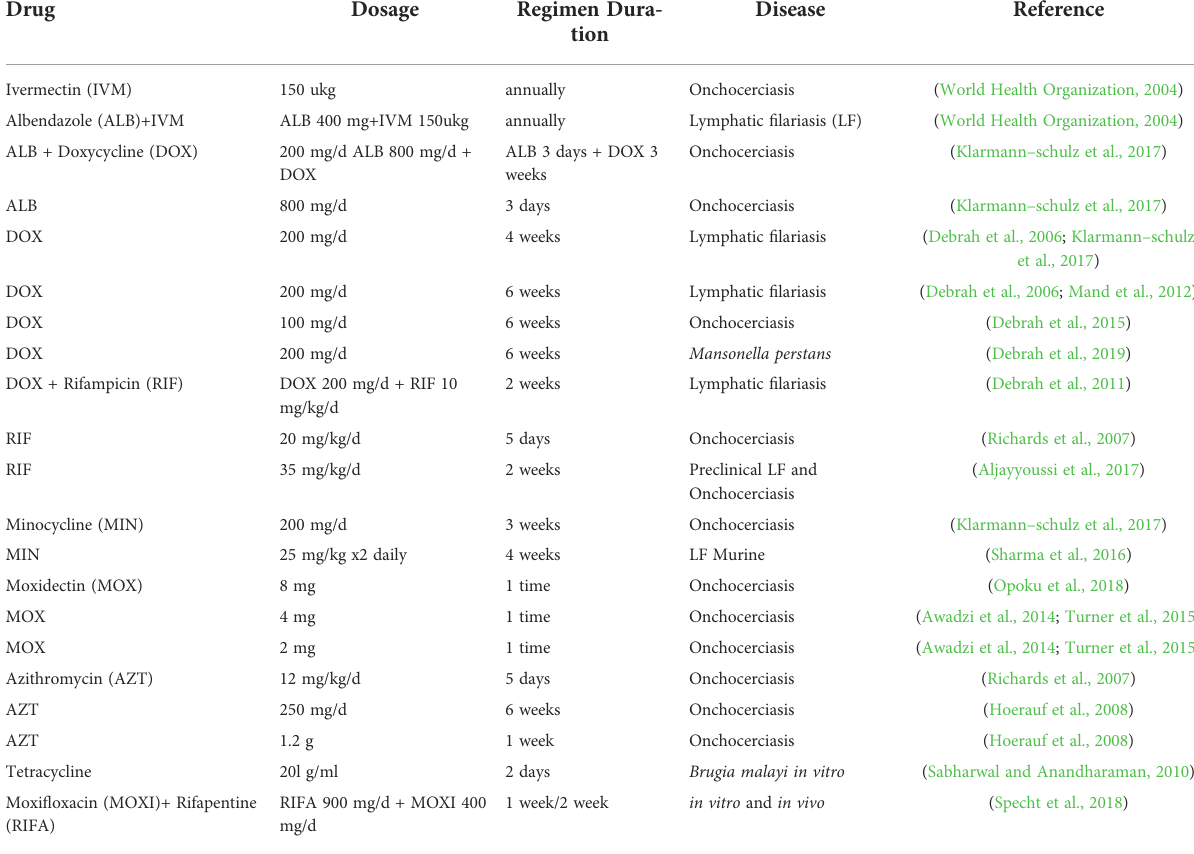
TABLE 1 Anti- fi larial drugs and their time effect ef fi cacies against the various forms of fi larial diseases.